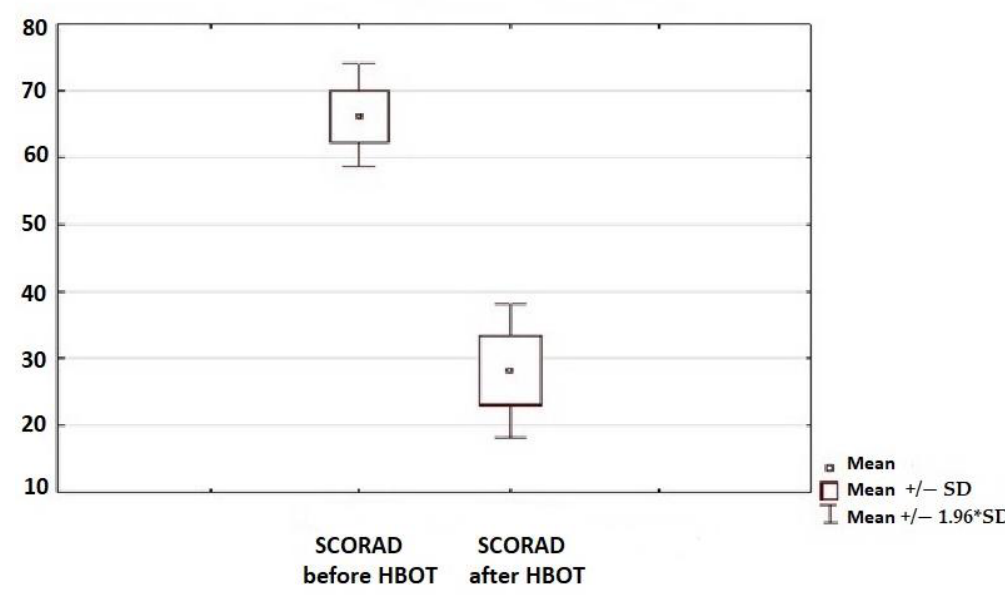
Figure 2. Assessment of the disease activity before and after hyperbaric oxygen therapy (HBOT) with the use of the SCORAD method ( p <